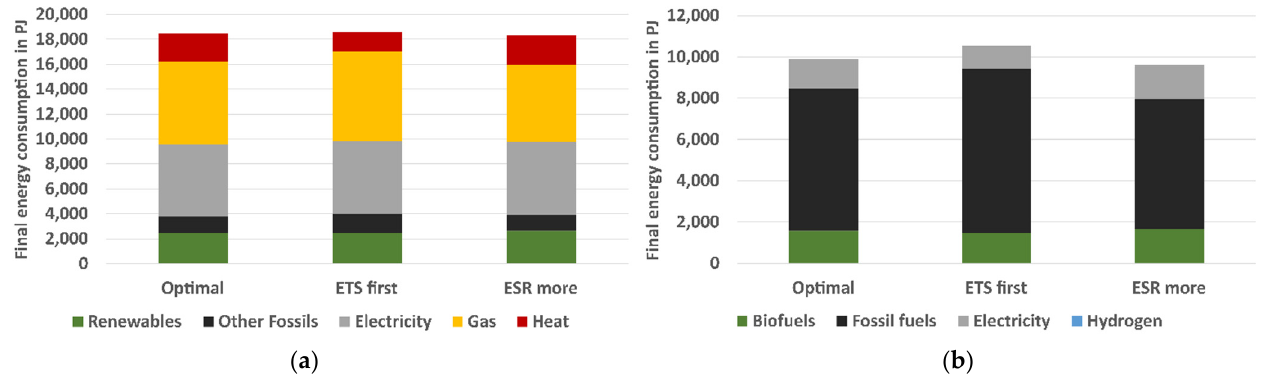
Figure 5. Final energy consumption in 2030 for ( a ) residential and commercial buildings and ( b ) the transport sector.